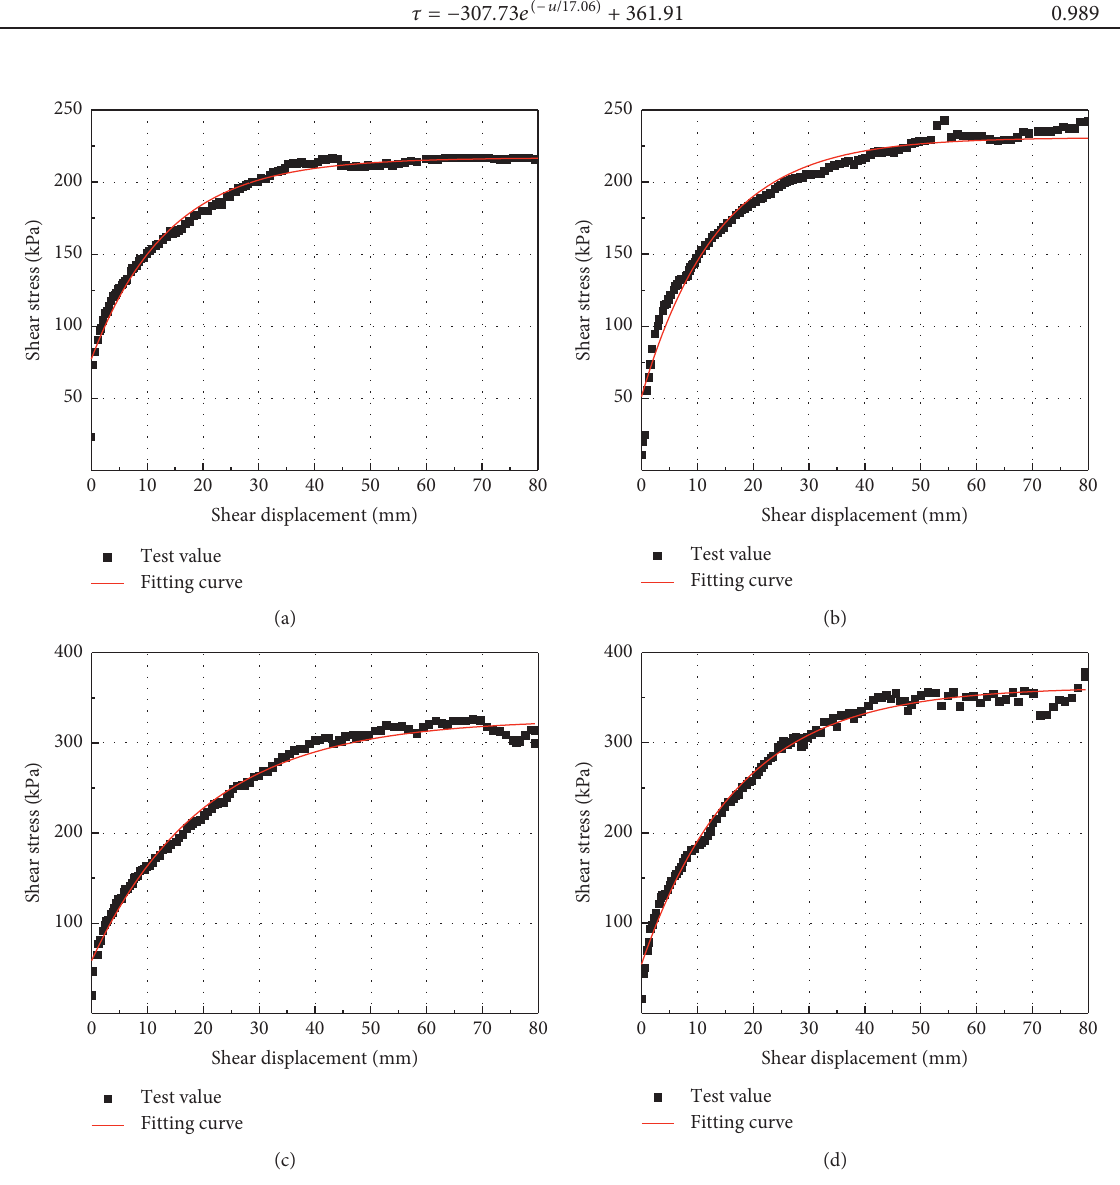
Figure 8: Shear stress-shear displacement fitting curve of sand and cobble soil with different CCs. (a) CC � 20%. (b) CC � 40%. (c) CC � 60%. (d) CC �